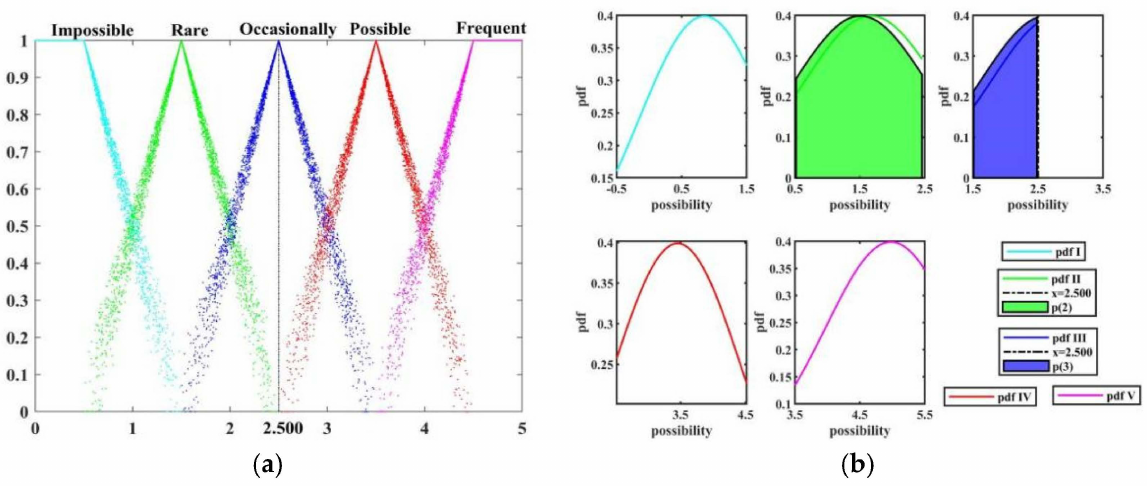
Figure 6. Comprehensive evaluation results ( P ). ( a ) Triangular cloud model, ( b ) probability density function (PDF).